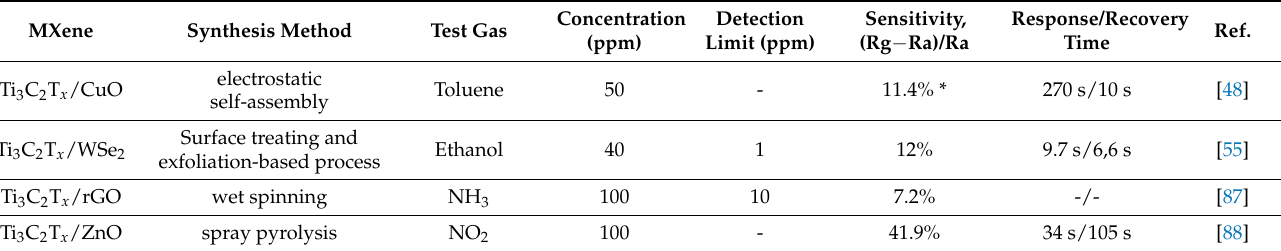
Table 2. List of the selected sensors based on MXene composite